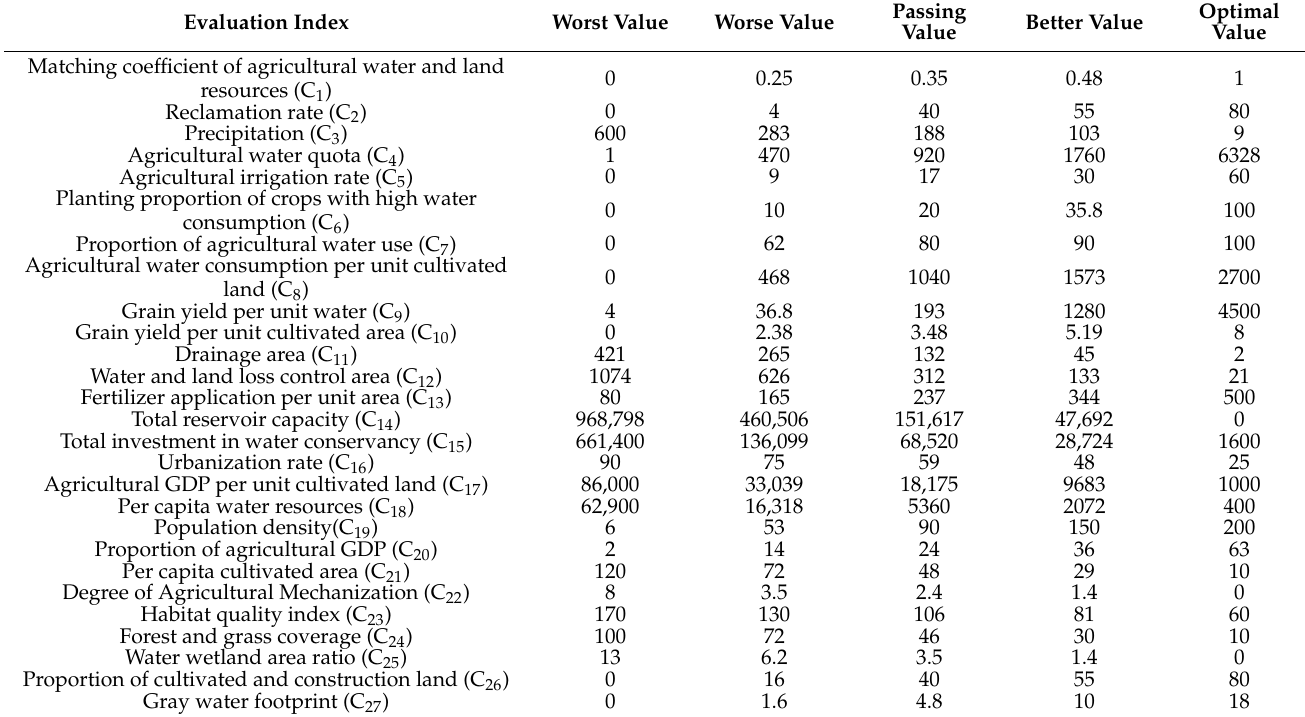
Table 2. Feature nodes of AWLRSV evaluation index.